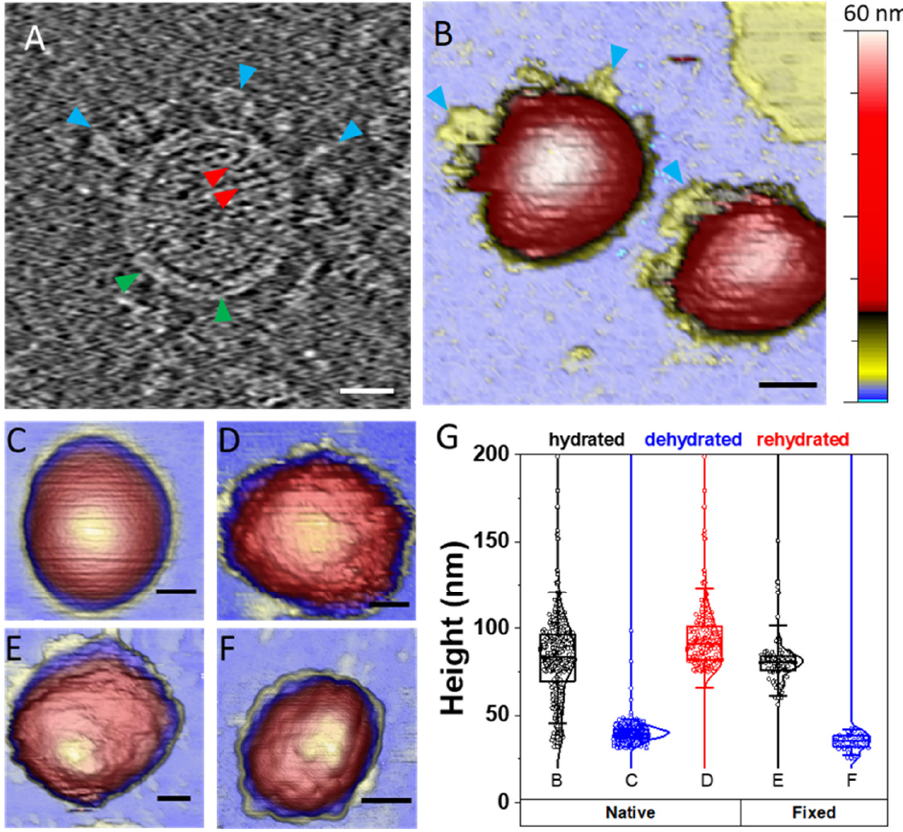
Figure 1. Structural characterization of TGEV virions ( A ) Cryo-electron tomogram presenting a section of a TGEV particle showing the spike proteins (blue arrowheads), the double layer membrane (green arrowheads) and the RNP wrapped inside (red arrowheads). Video S1 shows sections of a reconstructed cryotomogram of a group of purified TGEV virions ( B ) Intact virions visualized by AFM in a buffered solution. Blue arrowheads point to possible spike debris. The color bar shows the arbitrary color palette used for AFM image visualization, from 0 nm (blue) to 60 nm (white). Maximum color is set to the maximum height in each image ( C ) Dehydrated virion imaged in air conditions ( D ) Rehydrated virion imaged in liquid conditions ( E ) PFA-fixed virion imaged in liquid ( F ) Dehydrated PFA-fixed virion imaged in air ( G ) Height chart comparing the five populations with the corresponding AFM images labels. The native and fixed-hydrated populations had the same mean height, although the fixed particles had a narrower height distribution. Dehydration resulted in an average decrease in height of about 50 nm, although rehydration restored the height of native particles. Scale bars represent 50 nm unless otherwise indicated.